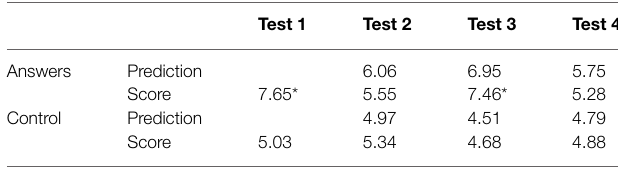
TABLE 2 | Study 2 scores and